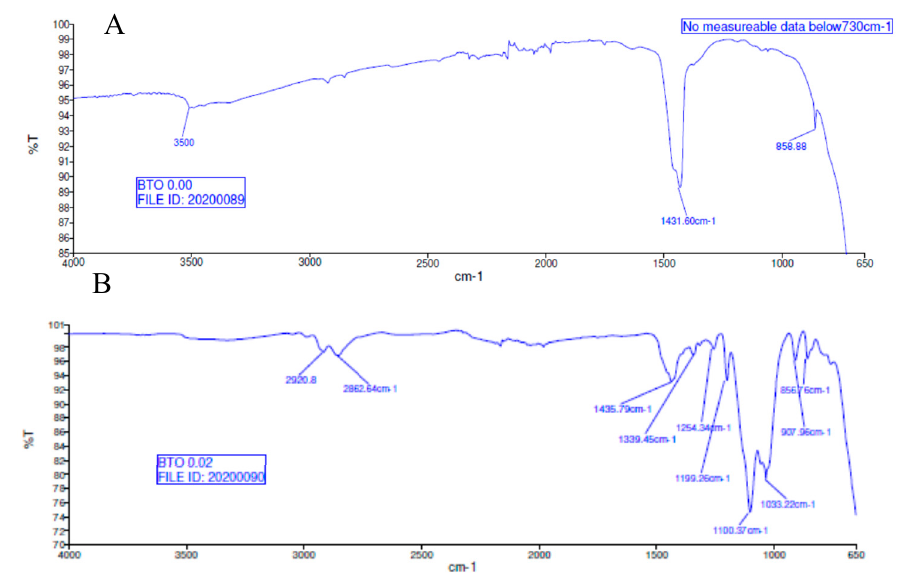
Figure 24. FTIR spectra of ( A ) BTO and ( B ) surface modified BTO particles.